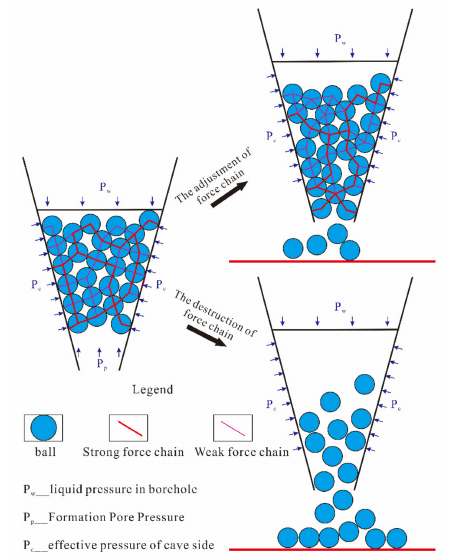
Figure 7. The continuous adjustment process of the first-stage